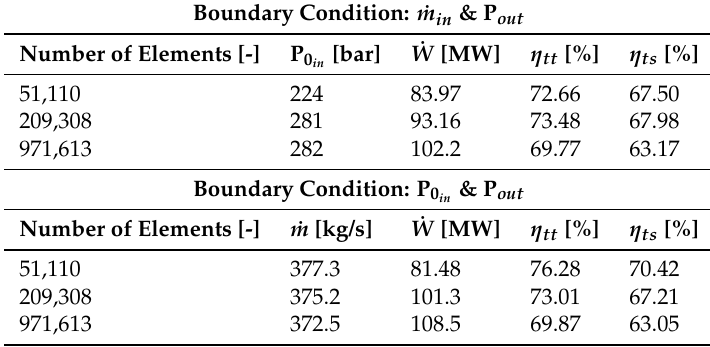
Table 8. Performance results for 3D CFD mesh sensitivity study using two different boundary condition